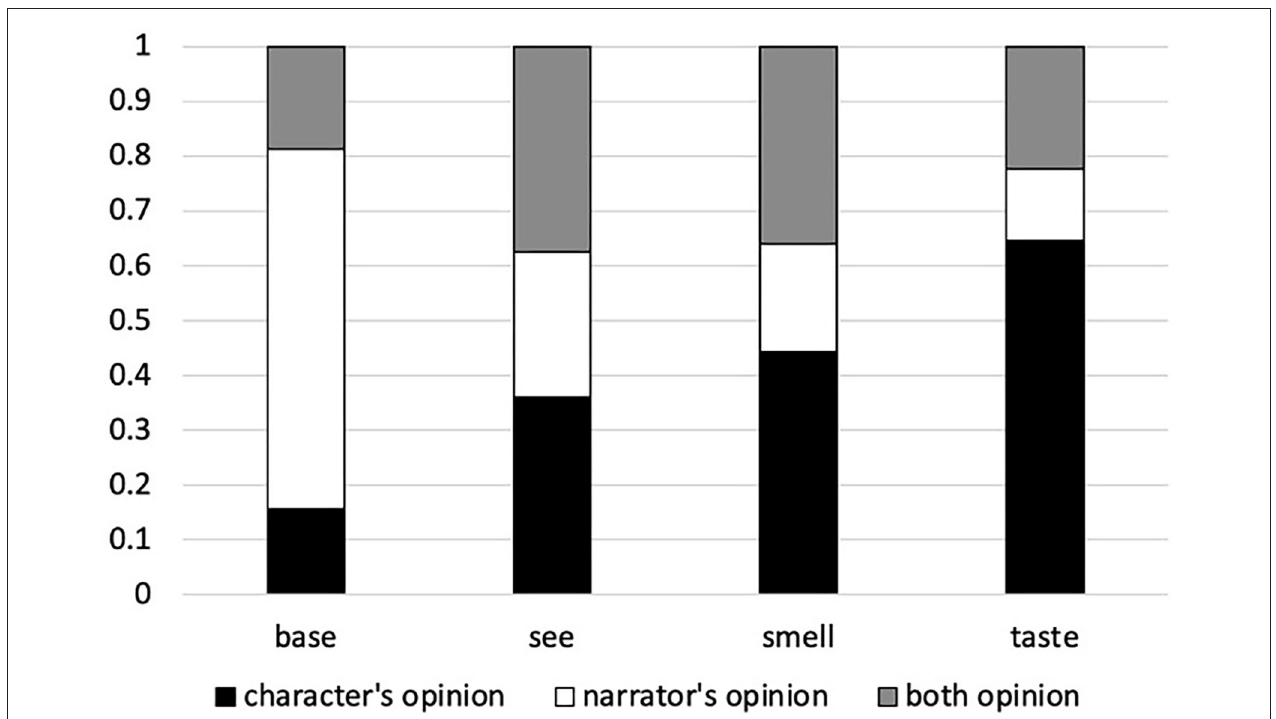
FIGURE 3 | Proportion of character’s opinion, narrator’s opinion and both answer choices in Experiment 3.